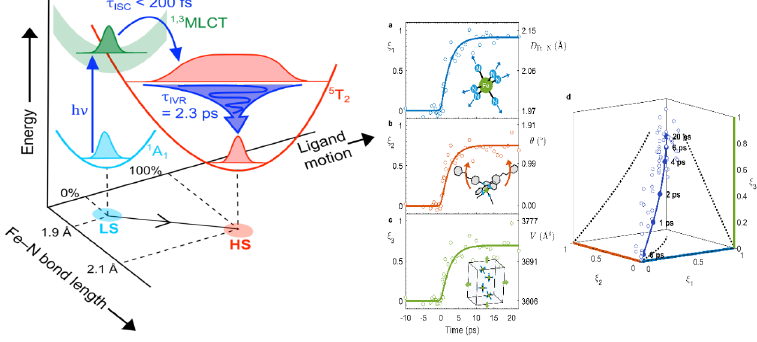
Fig. 4. Molecular movie. a)-c), Time- dependence of refined reaction coordinates. d), Plot of independent refinement over reaction-coordinate space